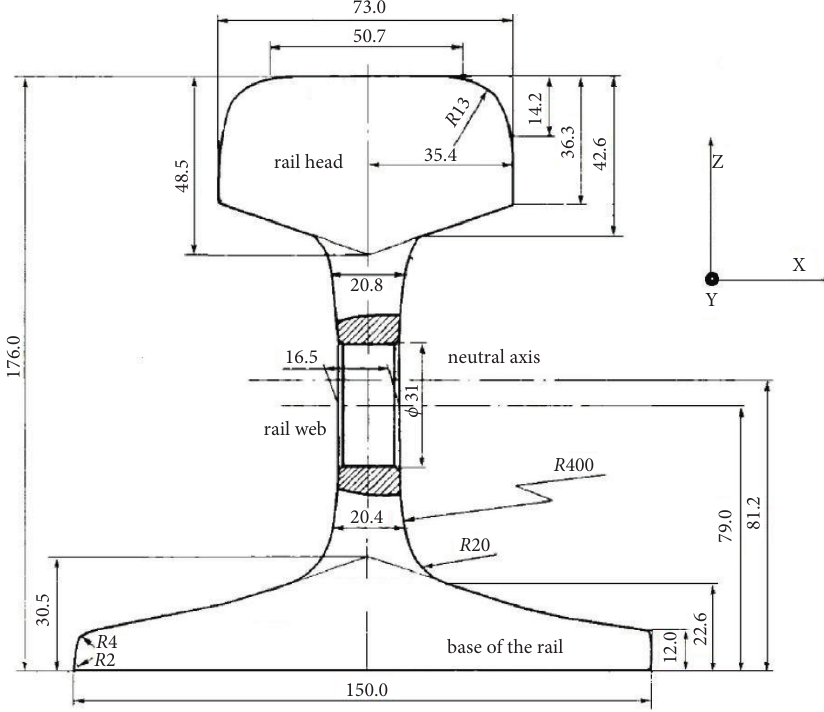
Figure 1: U71Mn rail profile (dimensions in mm).